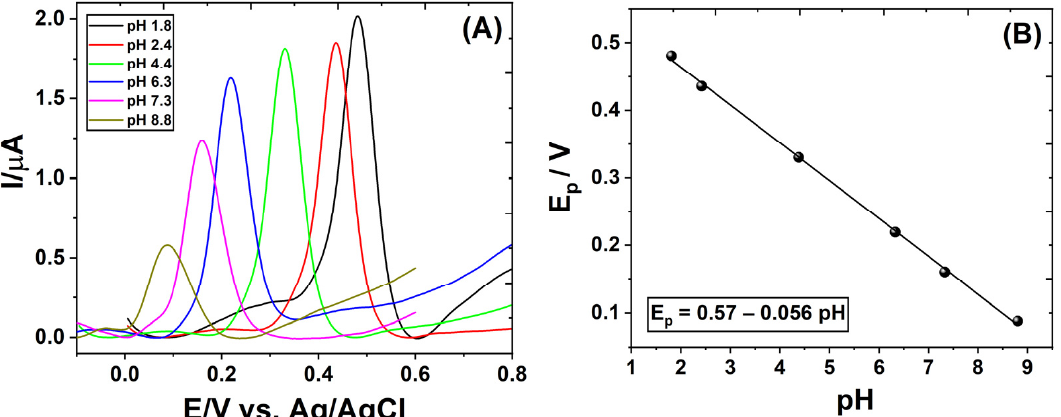
Figure 4. ( A ) SW voltammograms of 20 ppm PAs on GCE in 0.04 M B-R buffer solution at different pH values at frequency 10 Hz, pulse amplitude 25 mV, pulse width 1 mV. ( B ) E p vs. pH relationship.